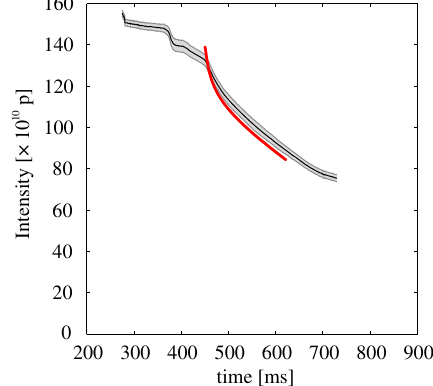
FIG. 7. Half-integer (short bunch). PTC-Orbit simulations vs measurements. Grey error bands are measurements, the red solid line are simulations with misalignment and quadrupolar field errors.